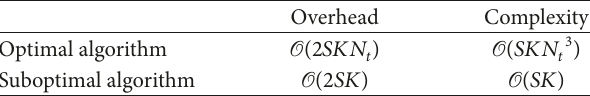
Table 3: Comparison of total overhead and complexity.